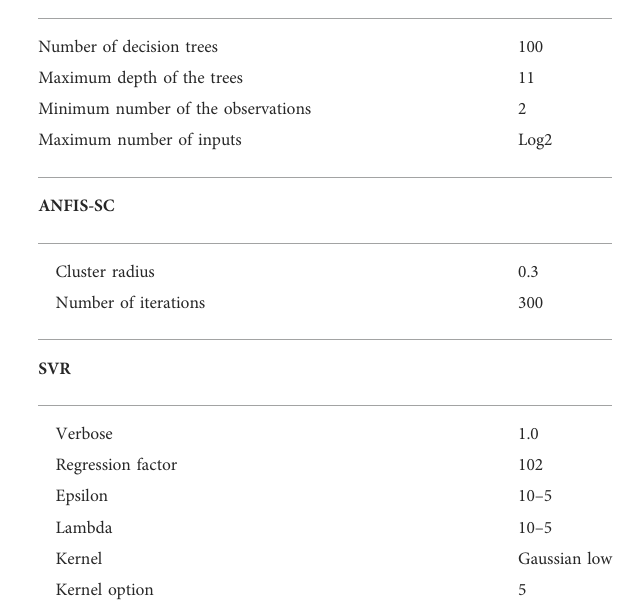
TABLE 3 Optimum ML algorithms design parameters for TOC estimation.